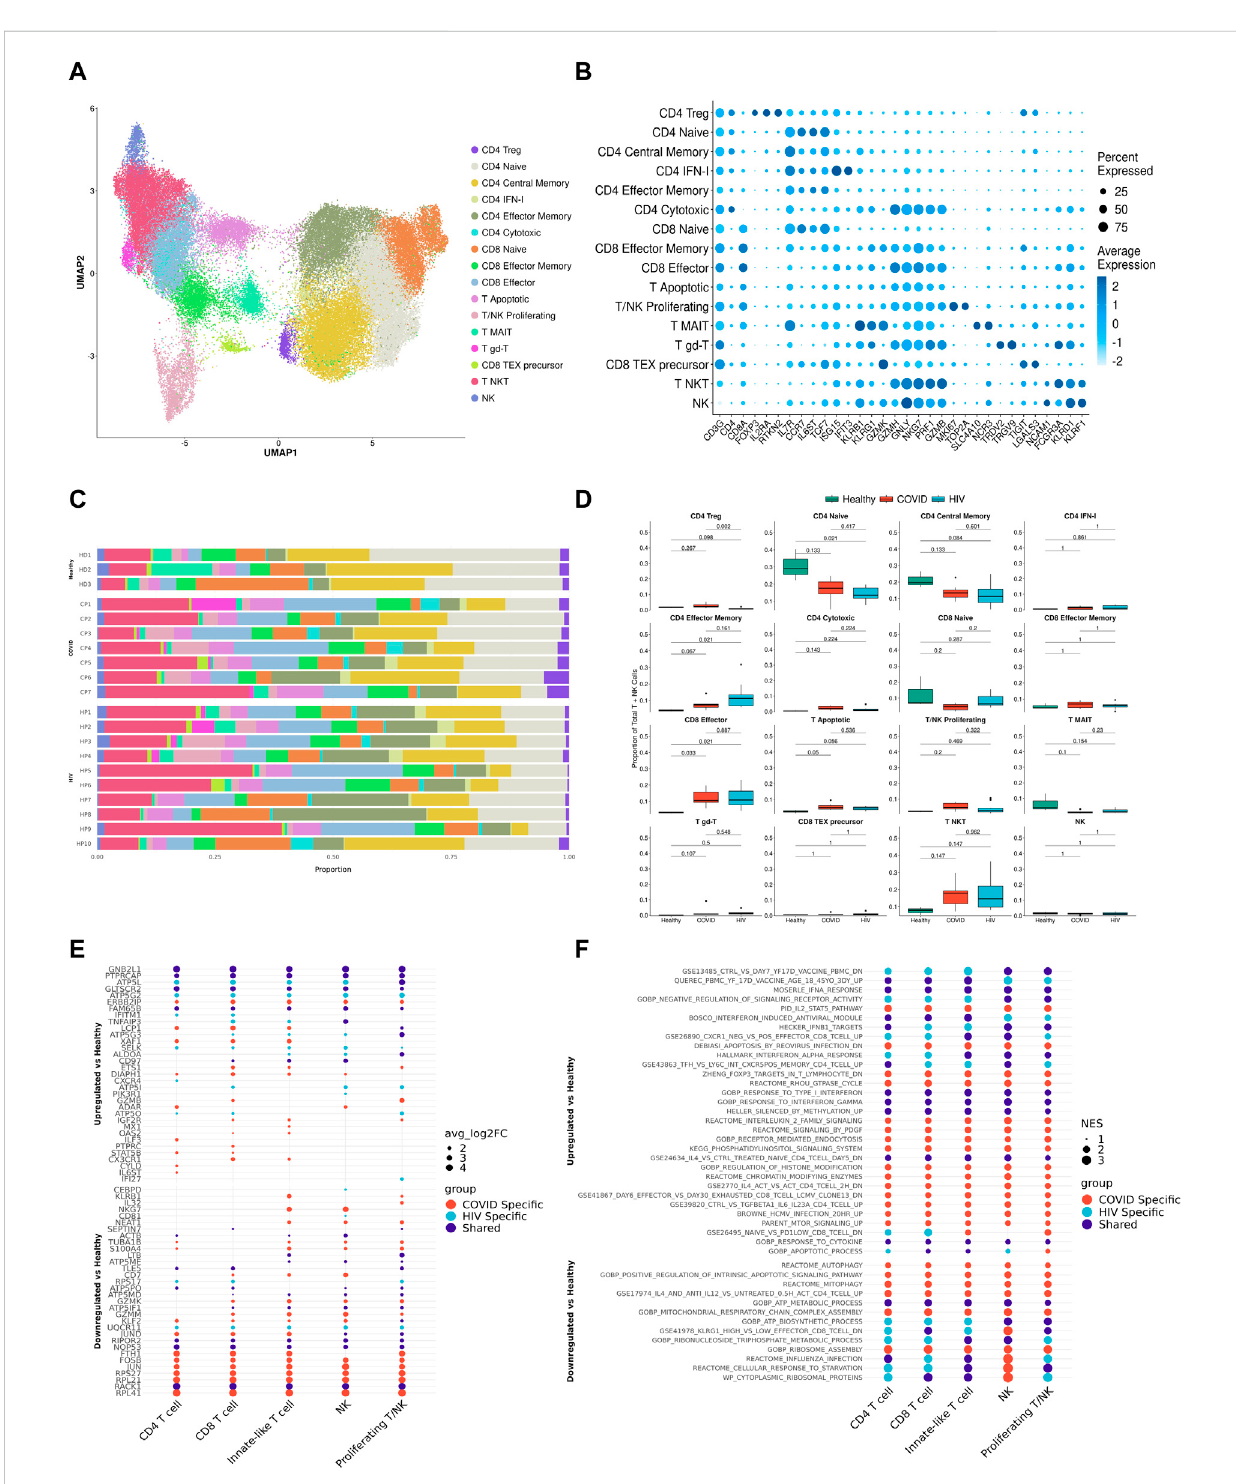
FIGURE 5 T cells in COVID-19 and HIV-1 show varied IFN-I and activation signatures. (A) UMAP embeddings of T cells colored by subtype. (B) Dot plot of canonical Tcell markerexpression acrosssubtypes. (C) Stackedbar plots ofthe relativefrequencyofsubtypes presentineach patient. (D) Figure 5D:Box plots of the proportions of each T/NK cell subset across each disease condition. Proportions are computed for each patient by dividing their number of cells in each T/NK subset by their total number of T + NK cells. p -values are computed with Wilcoxon signed-rank test with Holm-Bonferroni adjustment. (E) Dot plots of the key genes differentially upregulated (top) or downregulated (bottom) compared to healthy controls. (F) Dot plot of enriched biological pathways from differentially expressed genes that were found to be upregulated (top) or downregulated (bottom) compared to healthy